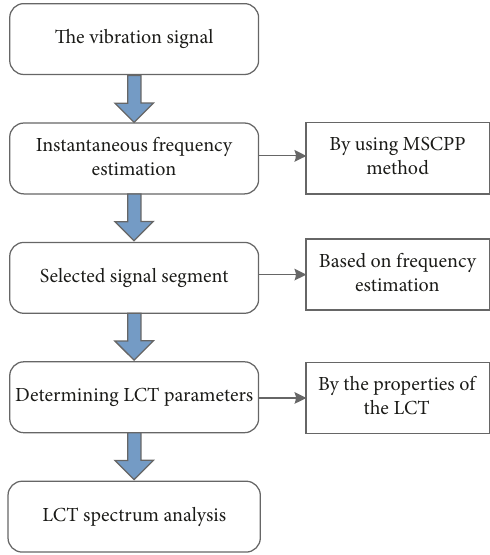
Figure 1: The block diagram of the proposed